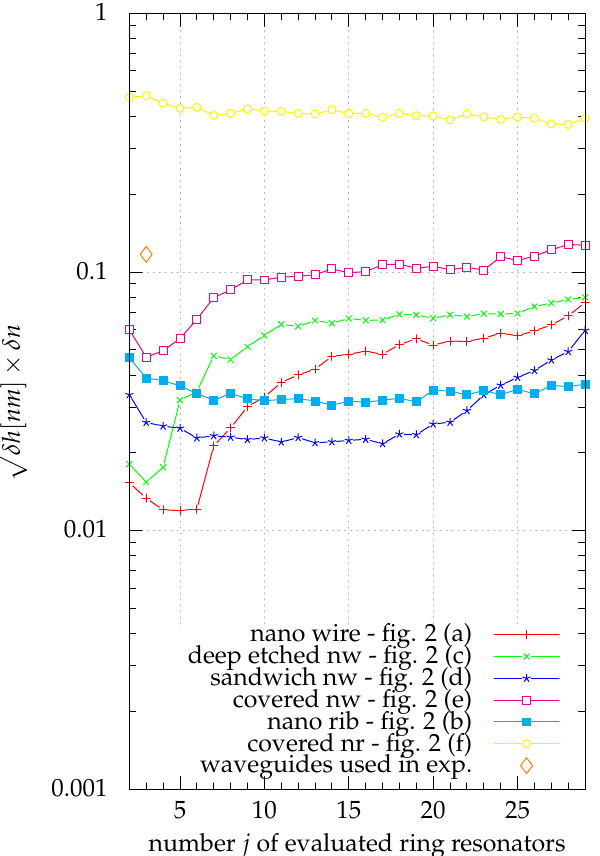
Figure 6. The geometrical mean of the precision in refractive index and in layer thickness (in nano meters) as a figure of merit for the sensor system is plotted over the number of different waveguides used for different waveguide geometries. The values here consider both the uncertainties caused by an offset of all waveguide widths by ± 1 nm as well as the wavelength accuracy of the resonance wavelength measurements. When not all waveguide widths were used, the combination with the lowest figure of merit was used. Comparing the results to Figure 5, it can be seen that geometrical variations of the waveguides can easily dominate the measurement